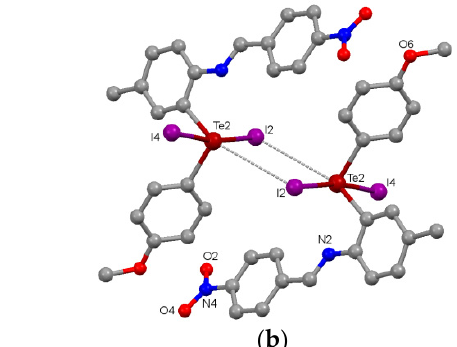
Molecules 2021 , 26 , x Figure 8. Two supramolecular synthons ( a ) Te---O and ( b ) [Te---Cl] 2 in the crystal of Figure 8. Two supramolecular synthons ( a ) Te—O and ( b ) [Te—Cl] 2 in the crystal of di-iodo-(2-(4-nitrobenzylideneamino)- di-iodo-(2-(4-nitrobenzylideneamino)-5-methylphenyl)-(4-methoxyphenyl)-tellurium (TARGAV). 5-methylphenyl)-(4-methoxyphenyl)-tellurium (TARGAV).